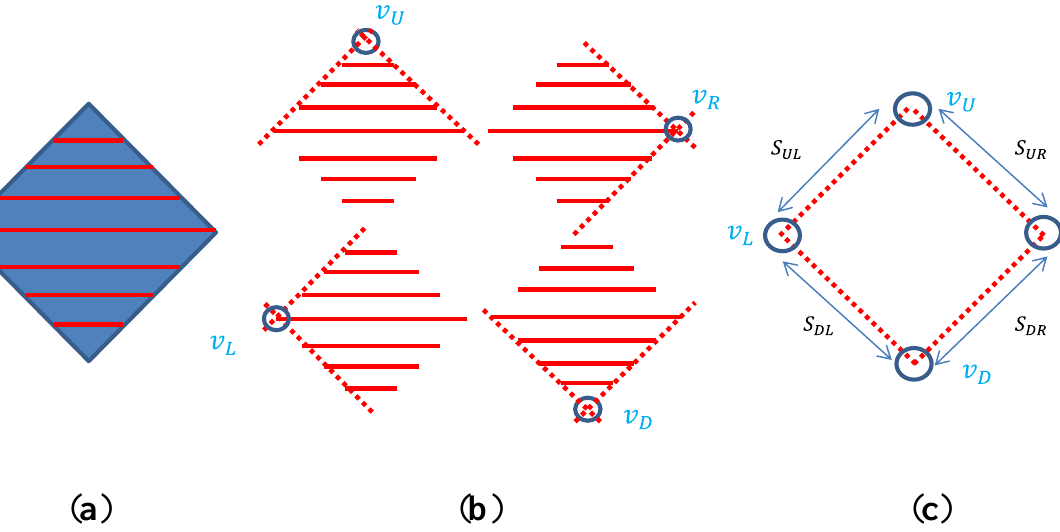
Figure 11. Diamond board with four vertices. ( a ) Scan lines on the board; ( b ) Vertex detection as an intersection of two adjacent sides; ( c ) Suitability test by accumulated errors between the real (known) length and estimated